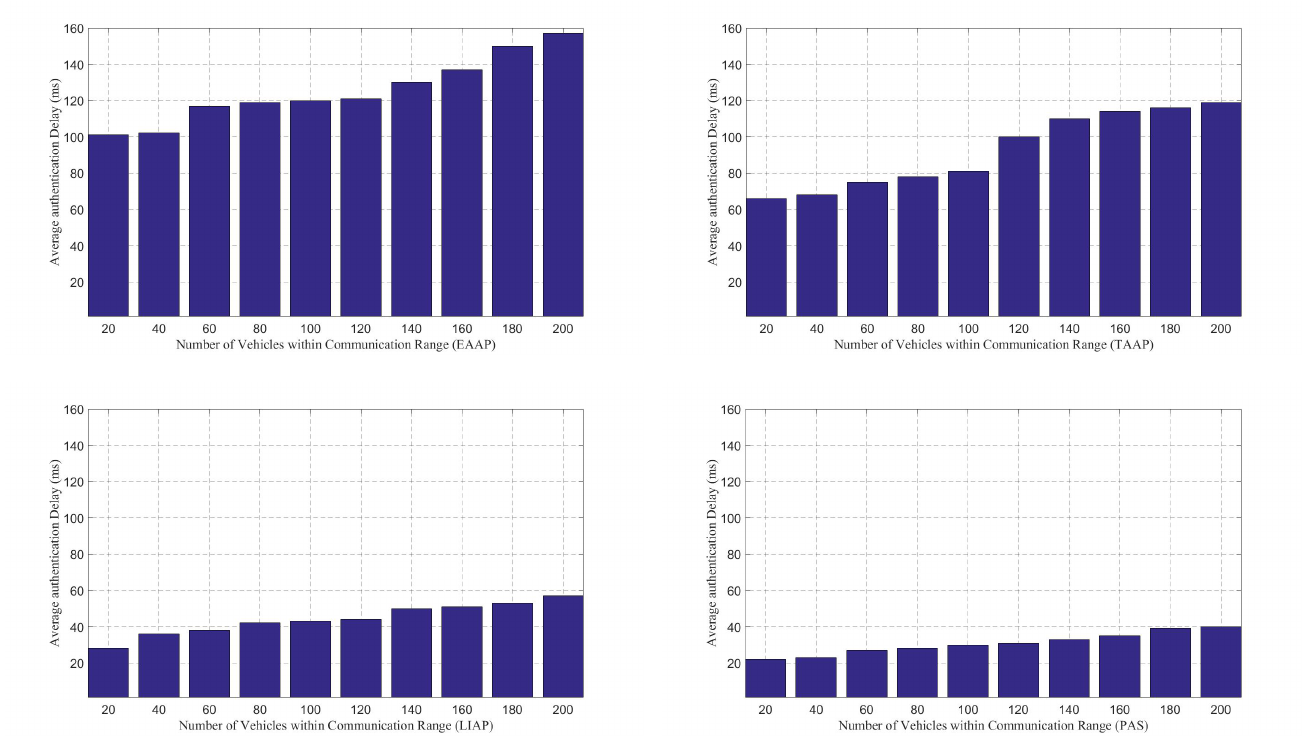
Figure 9. Average authentication delay of each scheme.